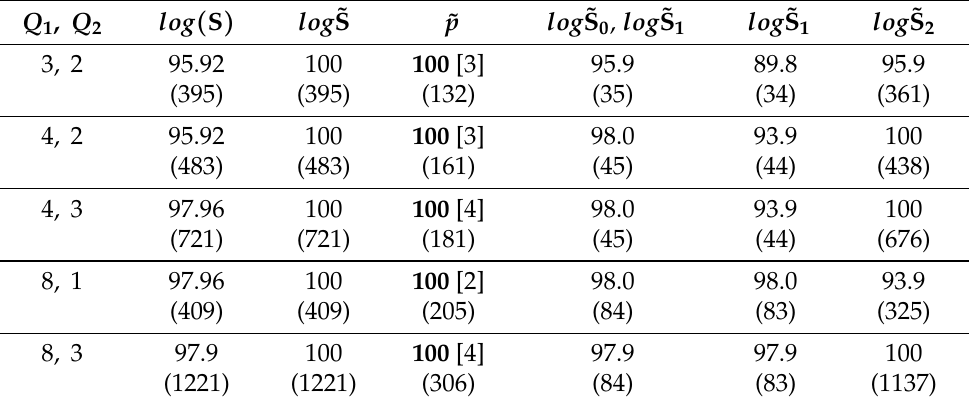
Table 1. Physionet dataset: Classification accuracy (%) for different couples of Q factors. The feature matrix consists of the logarithm of: WST ( 2nd col ); normalized WST ( 3rd col ); the uniformly sampled feature matrix (normalized WST) using the estimated sampling step ˜ p , as in Equation (20) ( 4th col ); normalized WST coefficients which, respectively, belong to the 0th and 1st layer, only the 1st layer, only the 2nd layer ( last three cols ). The number of features for each time t is in round brackets, while the value of ˜ p is in square brackets. Best results are in